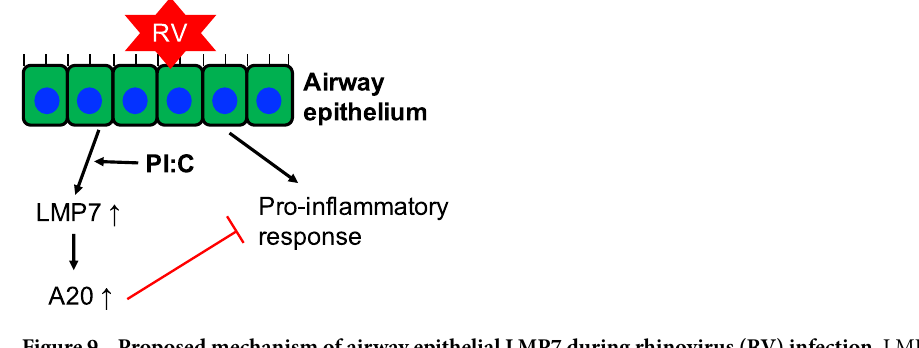
Figure 9. Proposed mechanism of airway epithelial LMP7 during rhinovirus (RV) infection . LMP7 induction by RV infection inhibits pro-inflammatory response through A20 upregulation. Also, administration of therapeutic low dose of polyinosinic:polycytidylic acid (PI:C) induces LMP7 to reduce RV-mediated